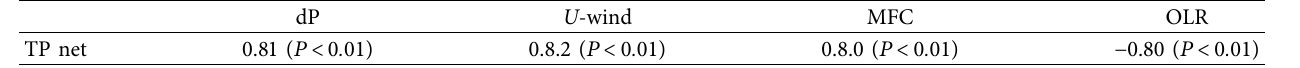
Table 1: Correlation values of parameters used in the CPI index.